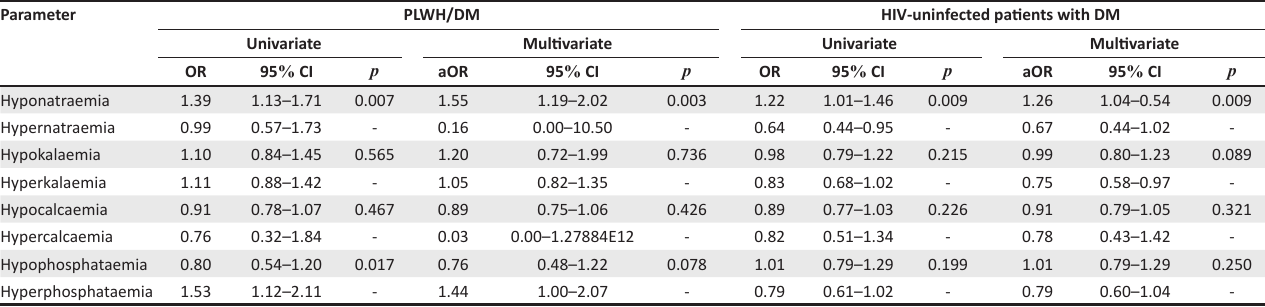
TABLE 3: Adjusted and un-adjusted odds ratio estimates for the associations of electrolyte abnormalities with glycated haemoglobin in people living with human immunodeficiency virus and diabetes mellitus, and human immunodeficiency virus-uninfected patients with diabetes mellitus. Parameter PLWH/DM